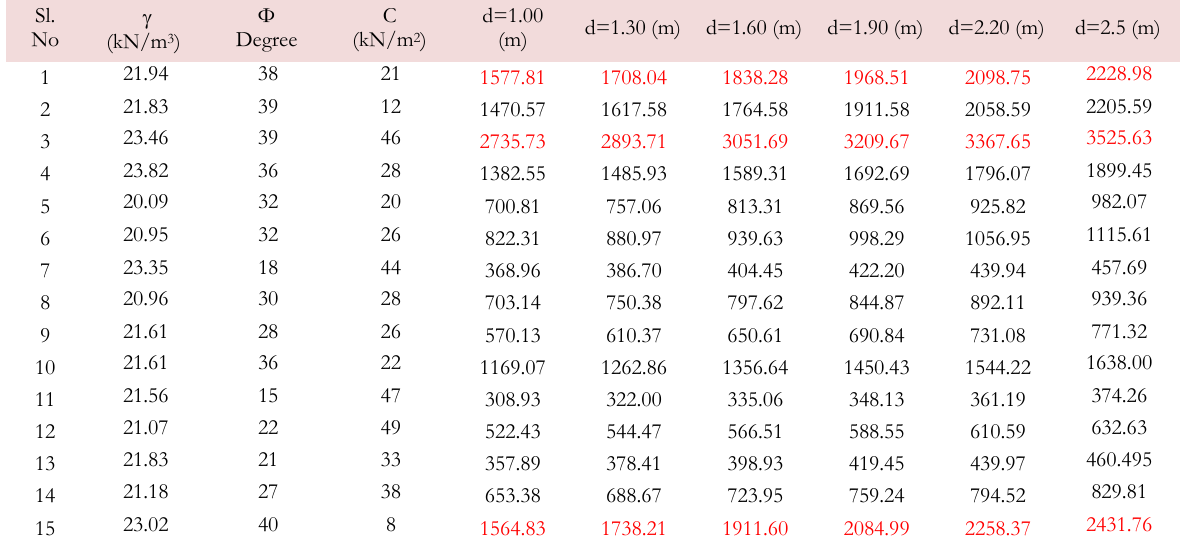
Table 2: Safe bearing capacity of soil foundation (kN/m 2 ) when width of square footing is 2.5